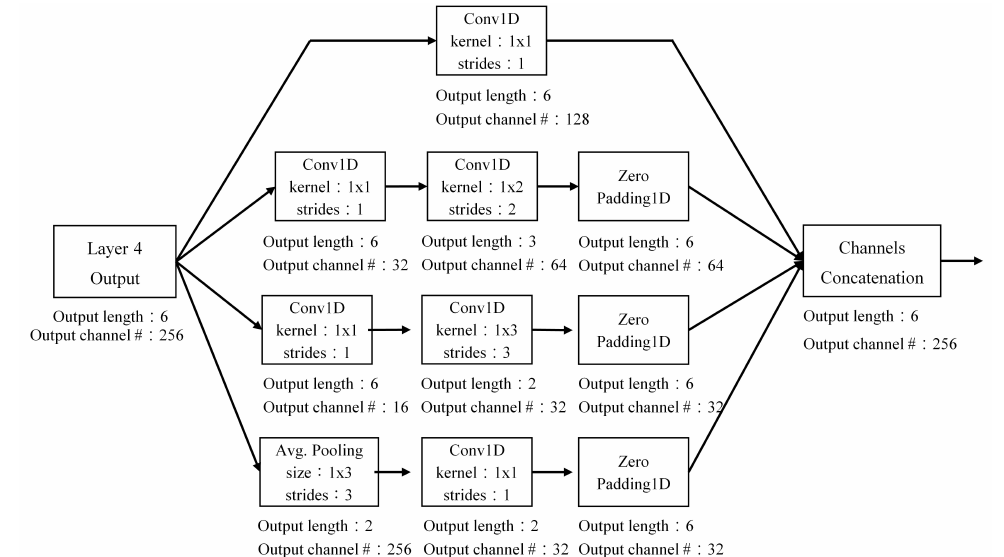
Figure 8. The parameters of the Inception module, which consists of four paths. Each path is associated with convolution modules, average pooling module, and/or a zero-padding module.